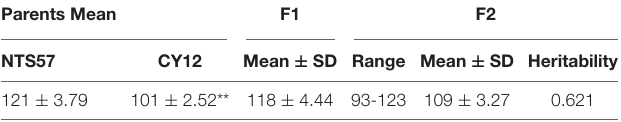
TABLE 1 | Statistical analysis of parents, F1, and F2 progeny for flowering time.